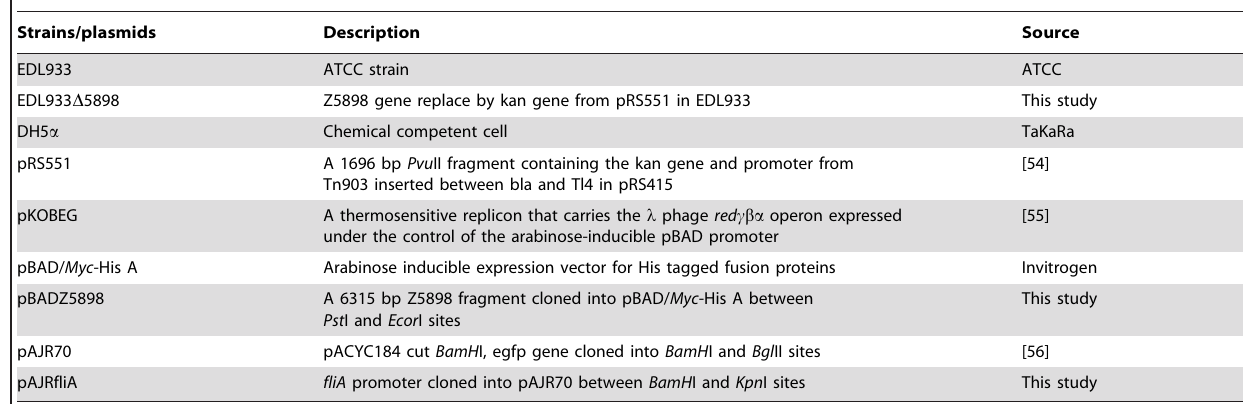
Table 1. Strains and plasmids used in this study.